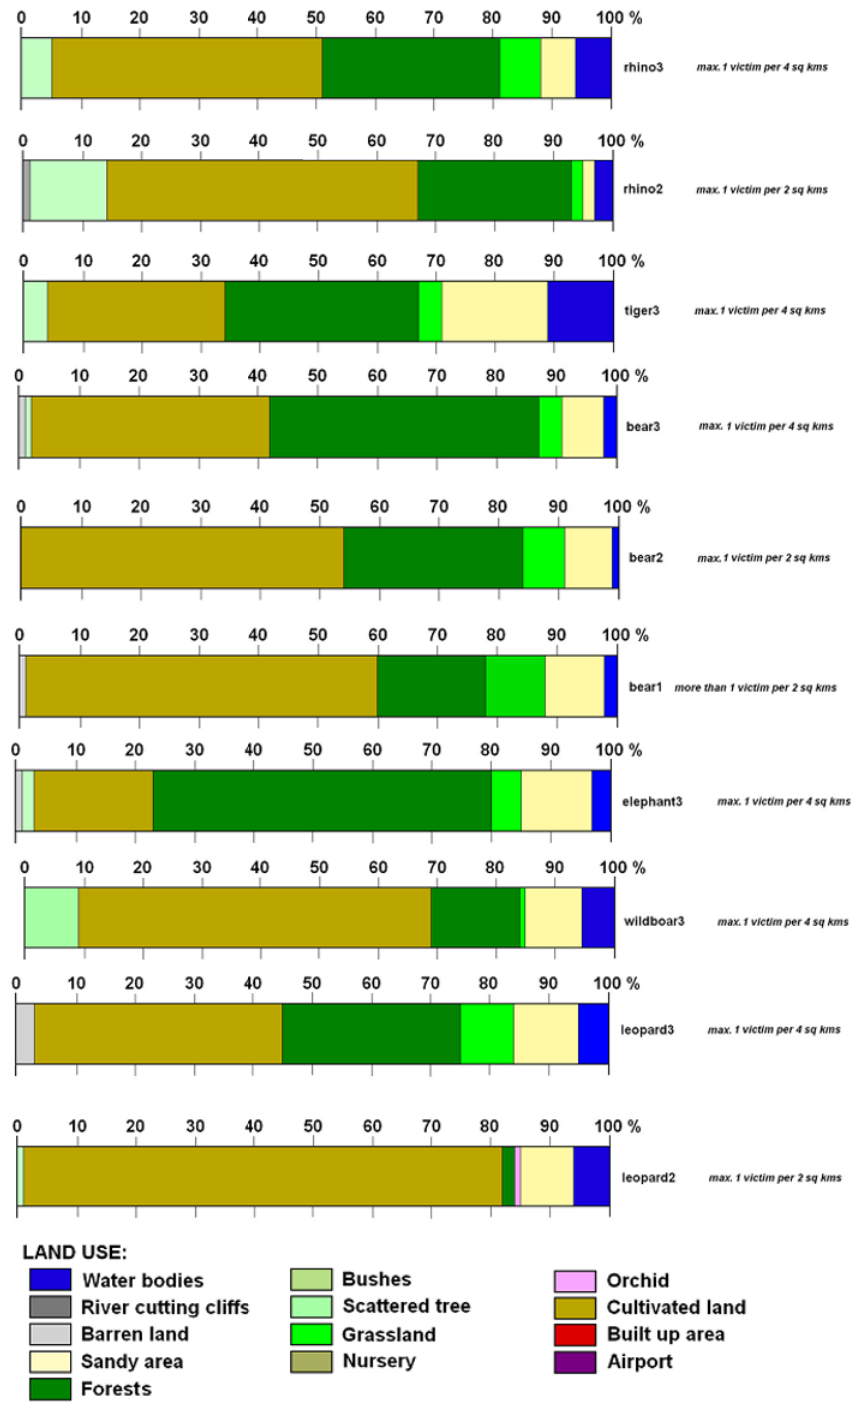
Figure 4. Share (1% or more) of di ff erent land use categories within operational areas of attacking animals.